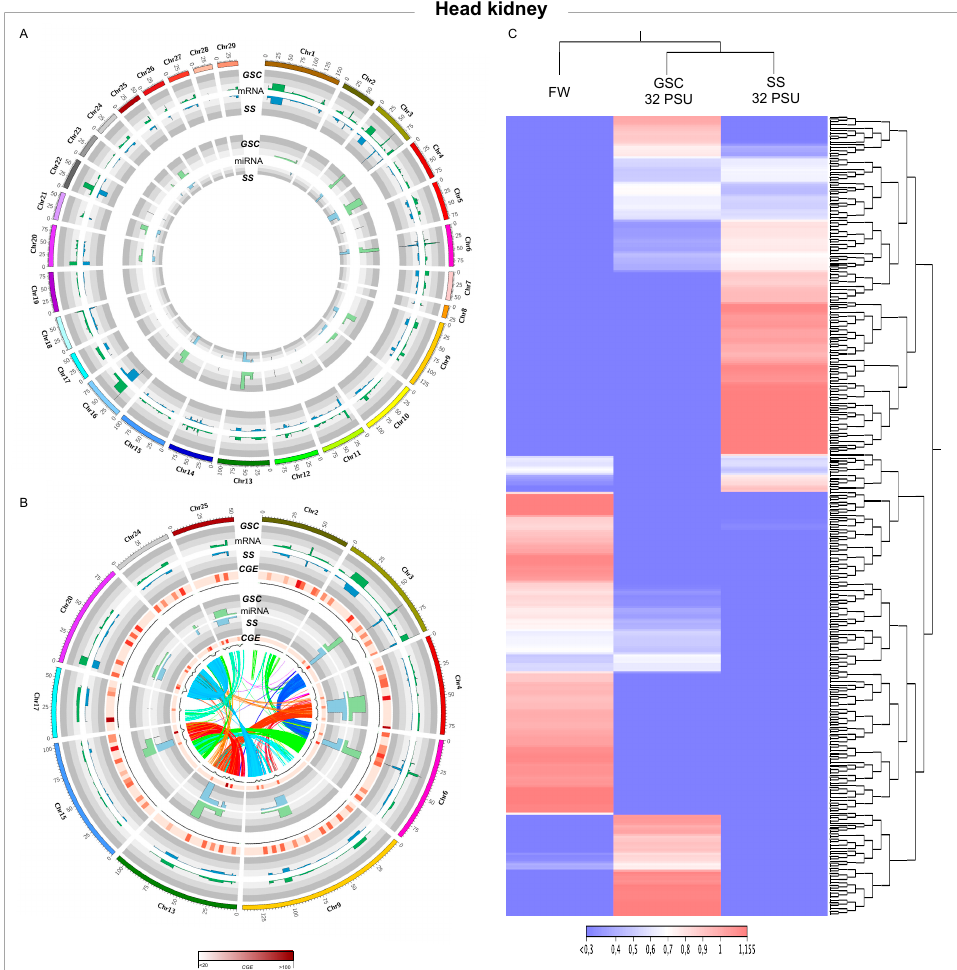
Figure 4. Whole-genome transcription in Atlantic salmon head kidney during smoltification process. ( A ) Threshold analysis of gills for GSC and SS fish groups. ( B ) Chromosome regions with high CGE index variation between GSC and SS fish groups. Heatmap in red shows the expression variation between both groups, CGE index. Black line graph indicates genome coverage of threshold areas. In the Circos plot, the ribbons represent the homoeologous regions in salmon genome. ( C ) RNA-Seq analysis of chromosome regions with high CGE index between experimental groups.